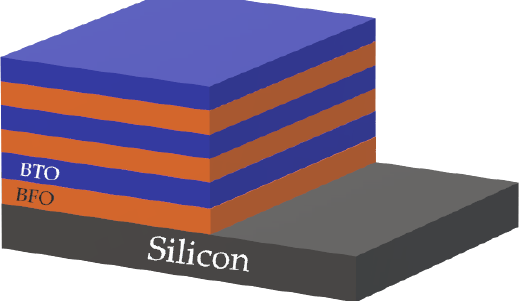
Figure 11. Multi – layer heterostructure of BFO BTO materials.